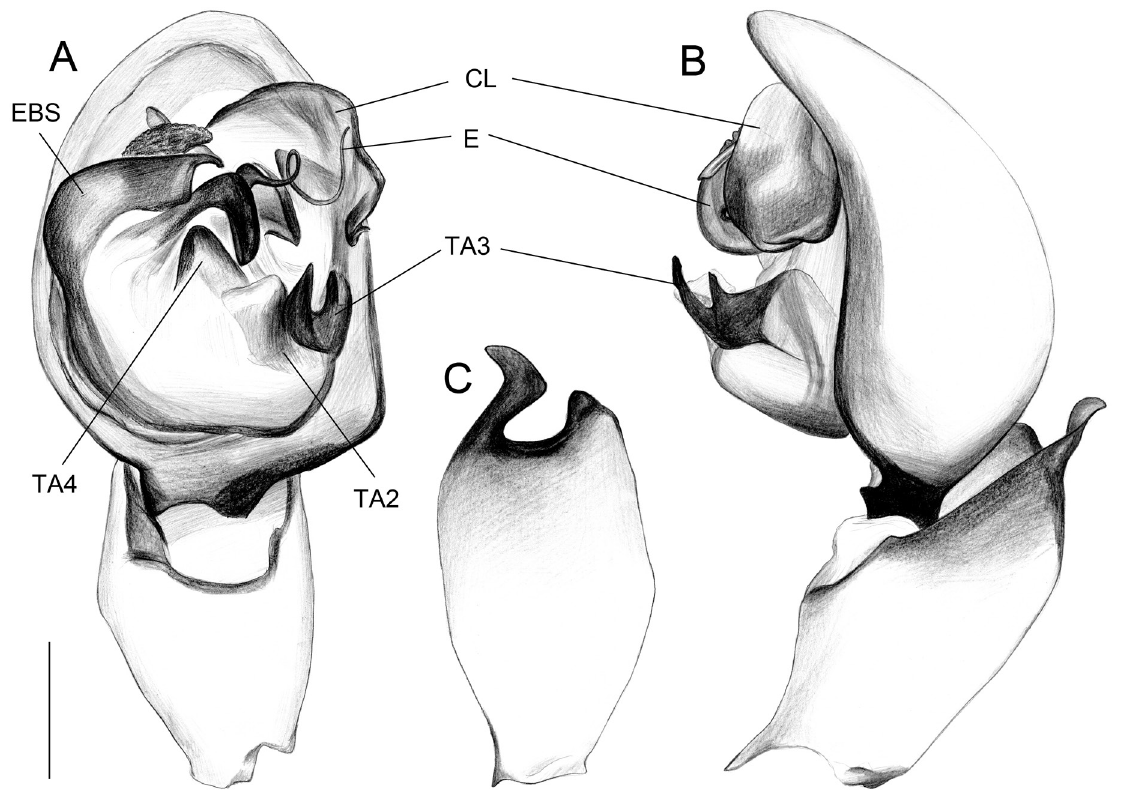
Fig. 3. Xevioso cepfi sp. nov., holotype, ♂ (RMCA_ARA_245493). A . Palp, ventral view. B . Palp, retrolateral view. C . Palpal tibia, dorsal view. Abbreviations: EBS = basal embolic sclerite; E = embolus; CL = lateral ridge of conductor; TA2, TA3, TA4 = tegular apophyses 2, 3 and 4. Scale bars = 200